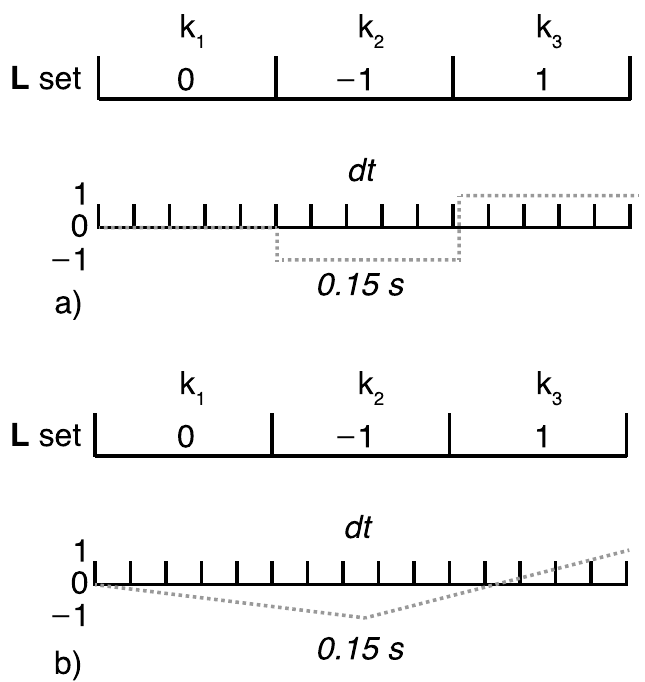
Figure 2. Interpolation approaches. ( a ) ZOH and ( b ) Linear. For each gimbal set in a class, the optimization algorithm runs for a set of commanded quaternions in order to obtain the data-set. The commanded quaternions are converted from Euler angles to quaternions because it is easier to describe and comprehend a maneuver as a rotation about roll, pitch, and yaw. The maneuvers given are: independent rotation about roll, pitch, yaw for π /6, π /2, 2 π /3, π , and all the possible permutations of two of those independent